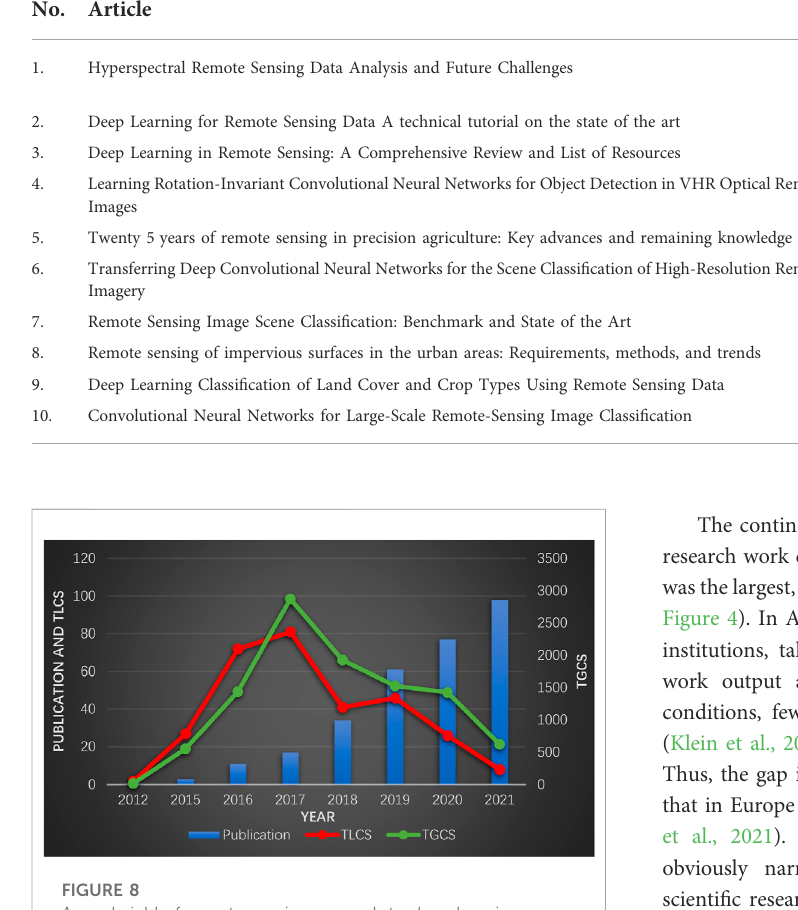
TABLE 6 Top 10 articles of remote sensing with the highest TGCS.